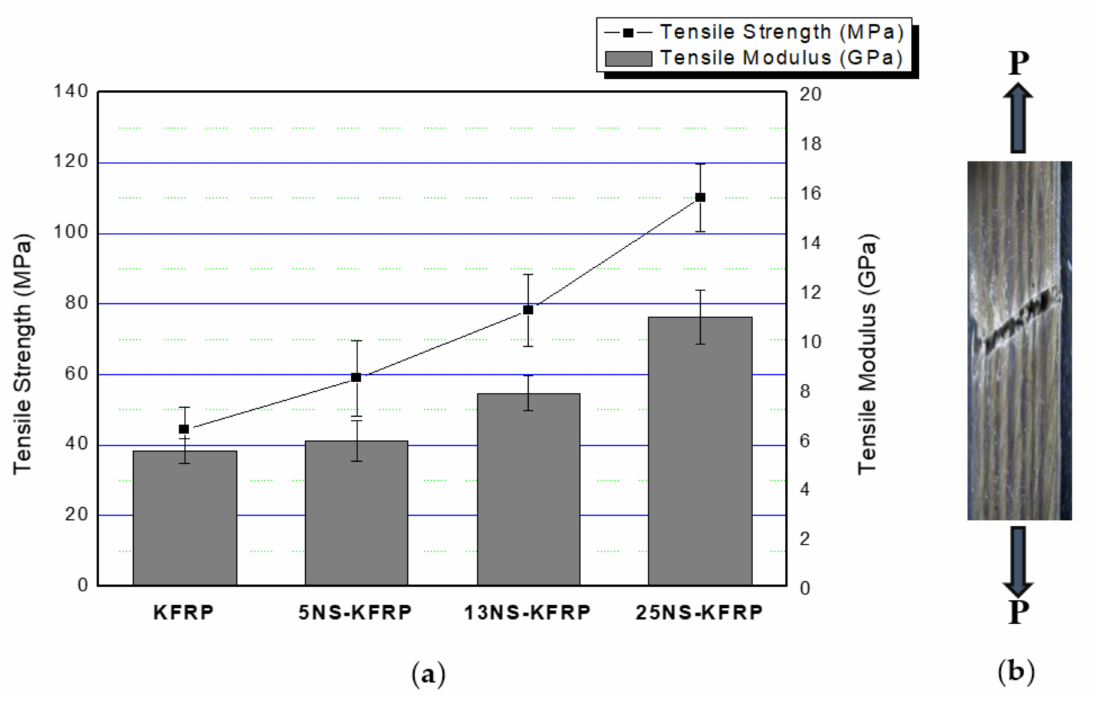
Figure 4. ( a ) Tensile properties of nanosilica-modified KFRP composites (5 wt % nanosilica in UD kenaf fiber reinforced polymer composites (5NS-KFRP), 13 wt % nanosilica in UD kenaf fiber reinforced polymer composites (13NS-KFRP) and 25 wt % nanosilica in hybrid woven glass / UD kenaf fiber reinforced polymer (25NS-KFRP)) compared with KFRP. ( b ) Example of fractured samples after tensile